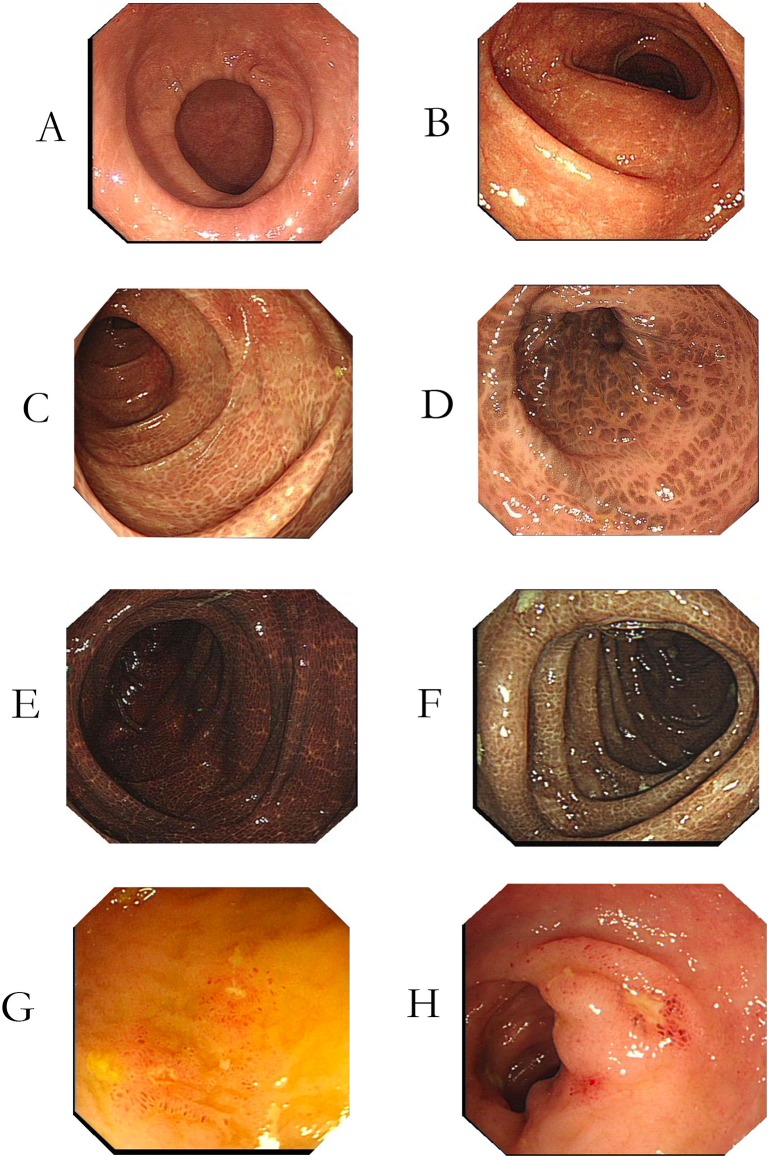
Melanosis coli of different grades and distal ileum ulcer.(A), (B): Melanosis coli Grade I, macroscopically appearing as light brown colonic mucosa, without clear boundary with normal mucosa (C), (D): Melanosis coli Grade II, macroscopically appearing as brown colonic mucosa, with clear linear or non-continuous boundary with normal mucosa. (E), (F): Melanosis coli Grade III, macroscopically appearing as dark black colonic mucosa with linear or spotted boundary with normal mucosa (G), (H): Distal ileum ulcers endoscopically discovered at six patients suffering from melanosis coli. The ulcers were multiple, small, and superficial, and mucosa around the ulcers seems normal. Pathology of the ulcers was all nonspecific inflammation.